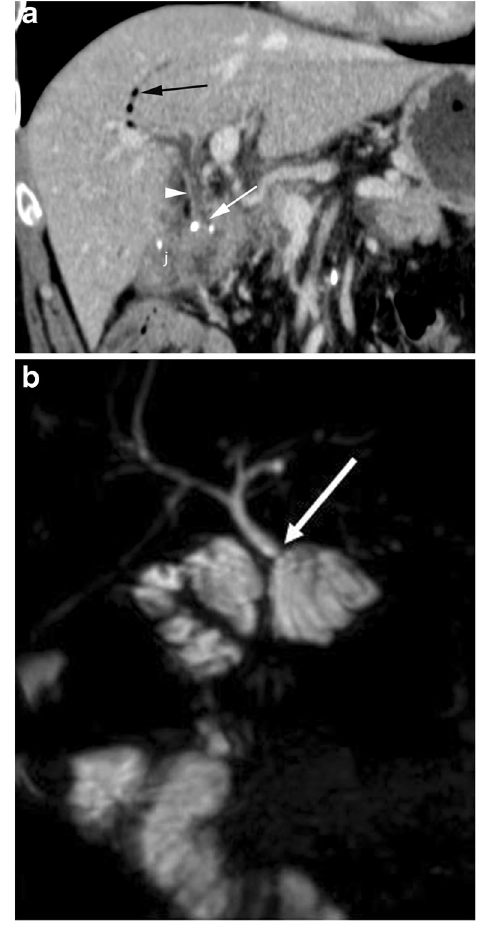
Fig. 7 Hepaticojejunostomy ( a , b ). a The hepaticojejunostomy (white arrow) and jejunum (j) are visible. The common hepatic duct (white arrowhead) is slightly dilated and a small amount of aerobilia (black arrow) is visualised. b MRCP better depicts the hepaticojejunostomy (white arrow)